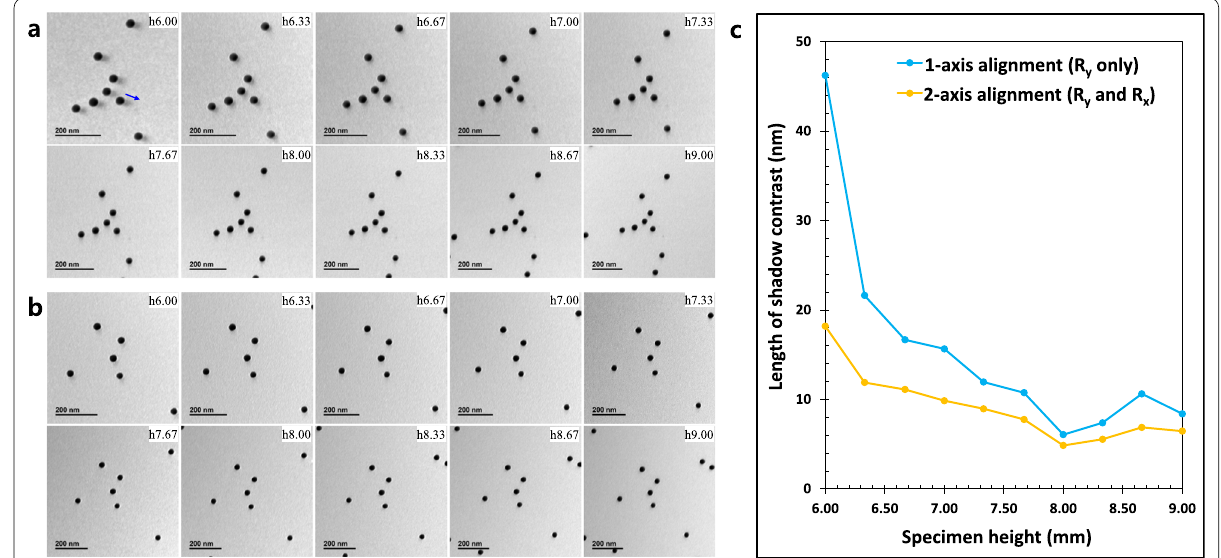
Fig. 5 Analysis results of imaging conditions of OL according to the mechanical alignment of OL P/Ps. a A series of shadow contrast images of AuNPs obtained for 1‑axis alignment of OL P/Ps. b Shadow contrast images of AuNPs obtained after performing the 2‑axes alignment of OL P/Ps. c Analysis results of the shadow contrast images for different SH positions